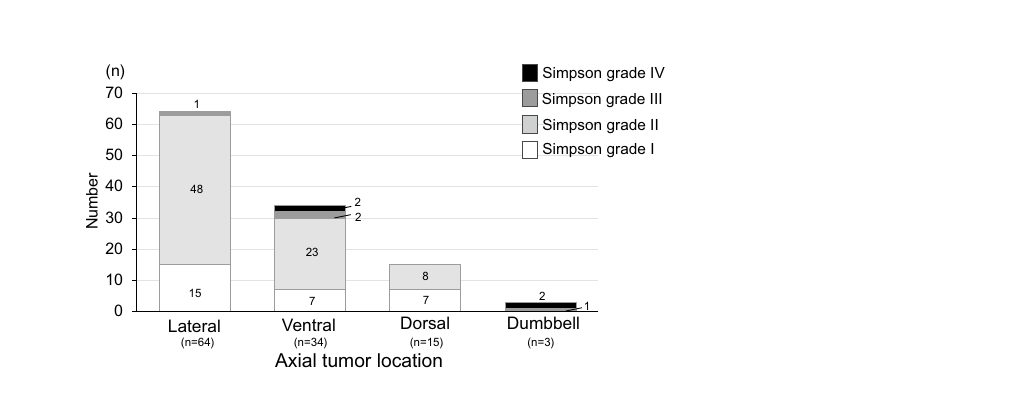
Figure 3. Simpson grade shown by axial tumor location.